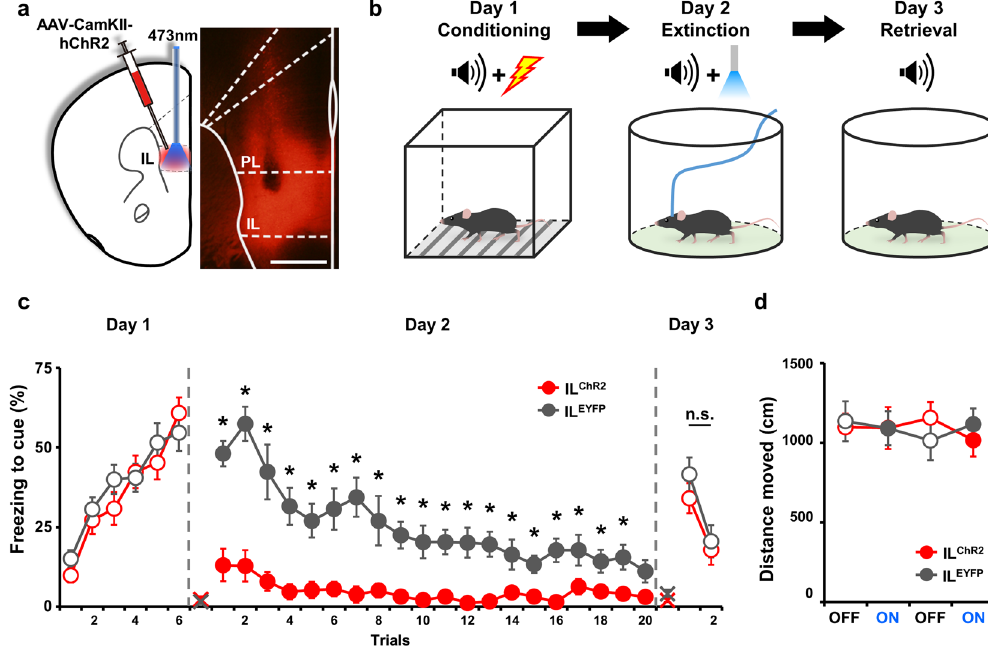
Figure 1. Stimulation of the IL during extinction training decreases freezing without affecting retrieval of extinction memory. ( a ) Schematic representation of AAV2/9-CamKIIa-hChR2(H143R)-mCherry infection and optic fiber placement in the IL. The schematic of the mouse brain is drawn based on the Franklin and Paxinos mouse brain atlas. Scale bar: 500 μ m. ( b ) Experimental procedure for extinction with optic stimulation. ( c ) ChR2 stimulation of the IL during extinction training decreased freezing to tone on day 2, but did not facilitate extinction retrieval tested on day 3 (IL ChR2 , n = 12; IL EYFP , n = 10). ( d ) ChR2 stimulation of the IL did not change the locomotor activity of mice in an open field (IL ChR2 , n = 9; IL EYFP , n = 9). Data are presented as means ± s.e.m. Empty circle, absence of optic stimulation; filled circle, presence of optic stimulation; X, baseline freezing